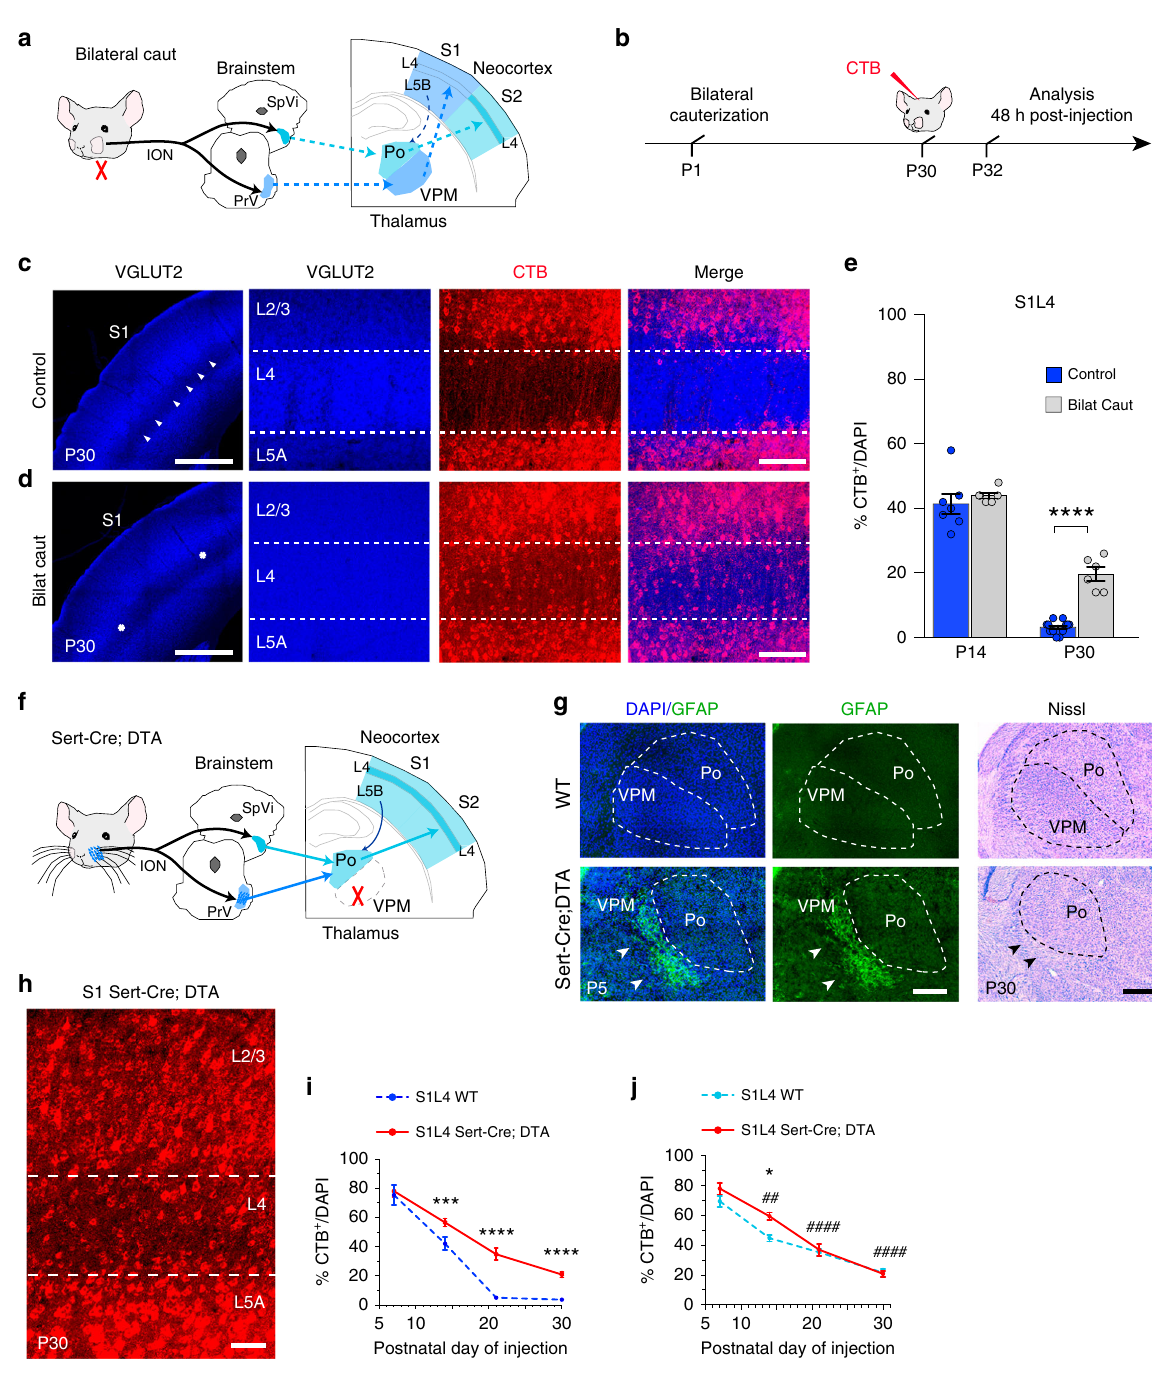
Fig. 6 Sensory input determines terminal stabilization of L4 callosal projections. a , b Scheme of whisker ablation experiments. ION = infraorbital nerve, PrV = principal trigeminal nuclei, SpVi = spinal trigeminal nuclei, Po = posterior nucleus, VPM = ventral posteromedial nucleus. c , d VGlut2 staining in control ( c ) and bilaterally cauterized animals ( d ). Arrowheads demarcate barrels. Stars delineate presumptive barrel fi eld. In red, CTB labeling. e Quanti fi cations ( n = 300 cells, n = 2 sections per animal, n = 3 animals per stage and condition). P value control vs. bilateral ≤ 0.0001 (two-way ANOVA ( n = 12): F control vs. bilateral (1, 25) = 24.51). **** P value control vs. bilateral ≤ 0.0001 (post hoc with Tukey ’ s test). f Scheme depicting genetic elimination of VPM. g Left and center panels show GFAP staining. Glial scars indicated by white arrowheads mark neuronal loss. At right, Nissl staining of P30 somatosensory thalamic nuclei in WT